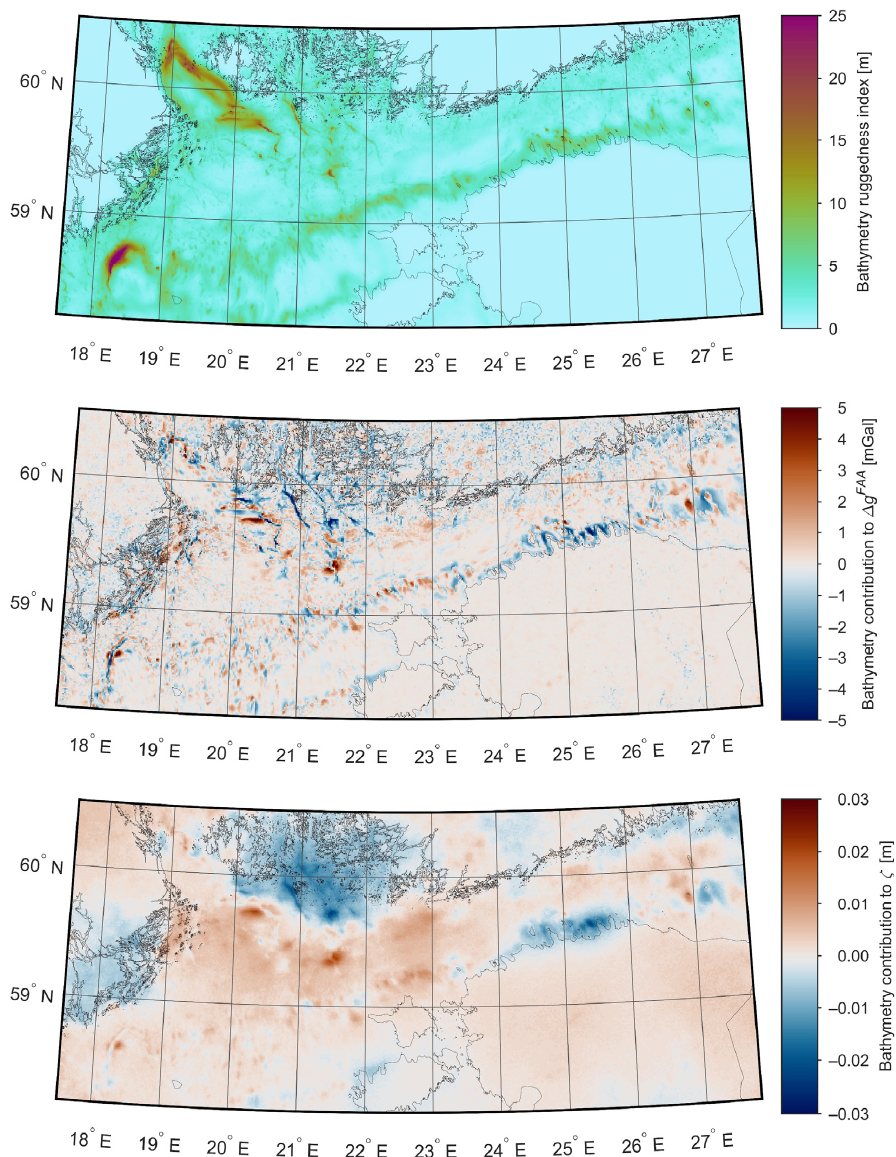
Figure 15. Bathymetry contribution to geoid modeling results. GGM: GOCO05c, modification limits: 200.